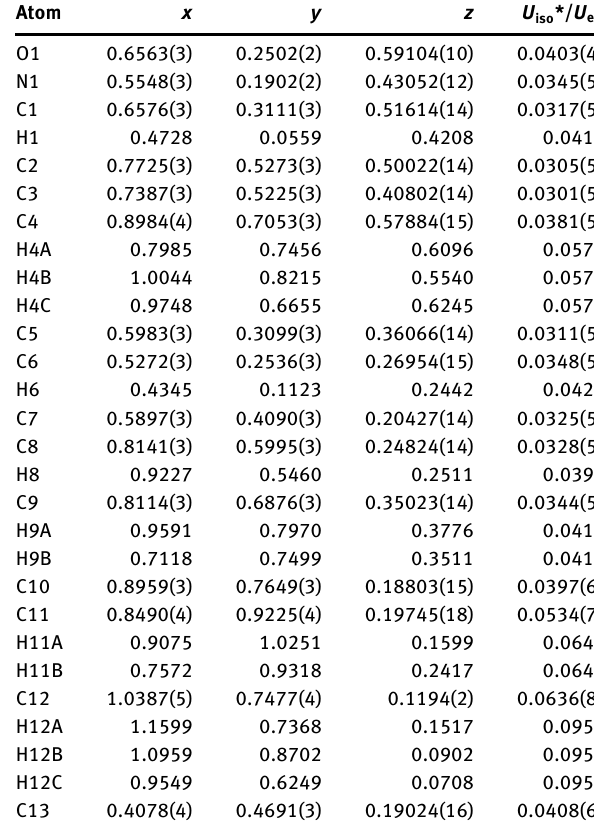
Table 2: Fractional atomic coordinates and isotropic or equivalent isotropic displacement parameters (Å 2